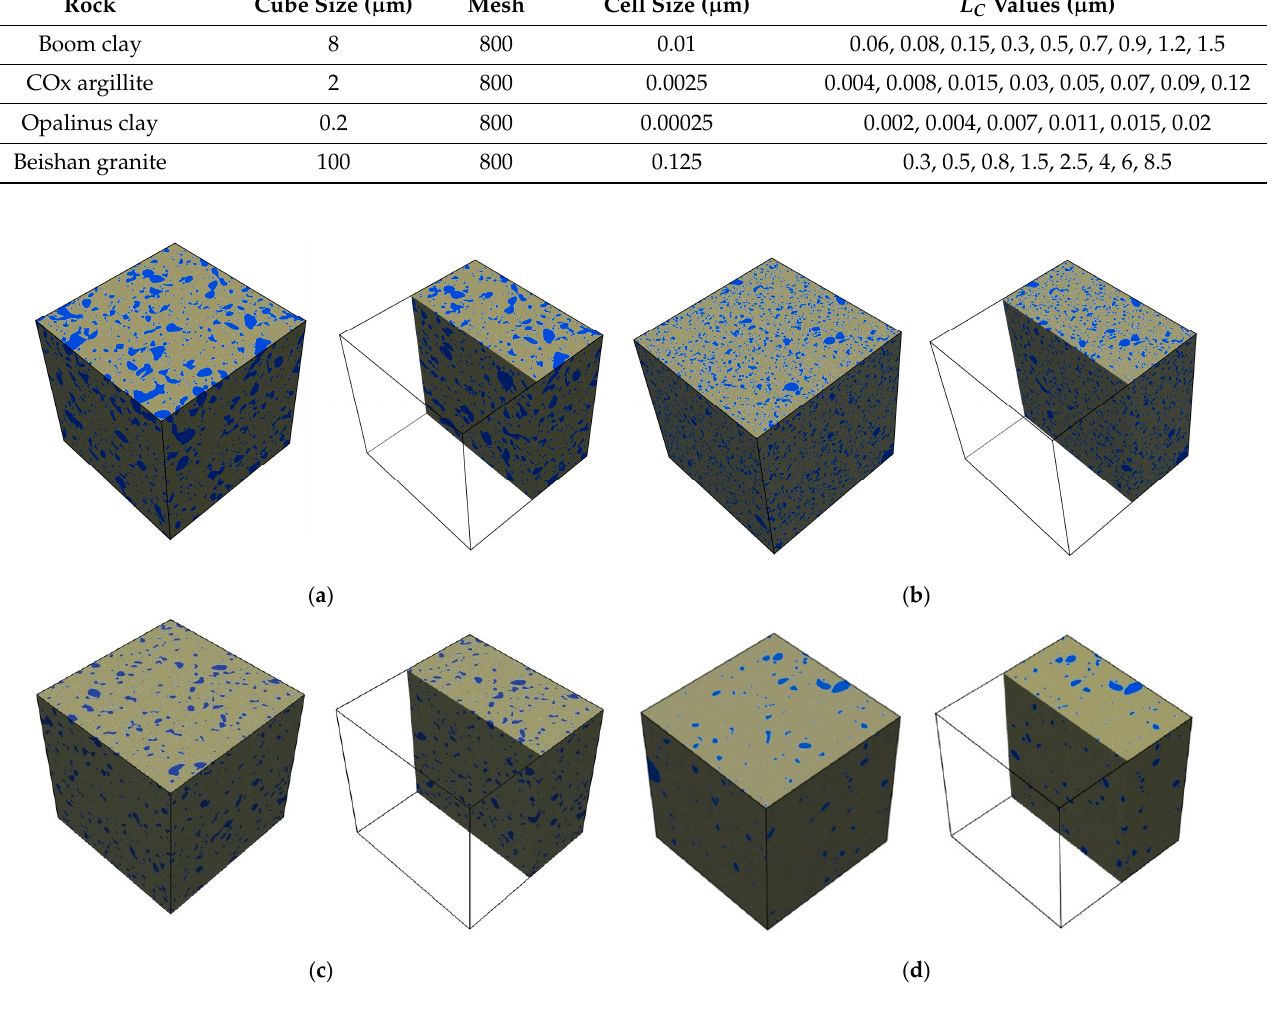
Table 2. Parameter used for the model generation.